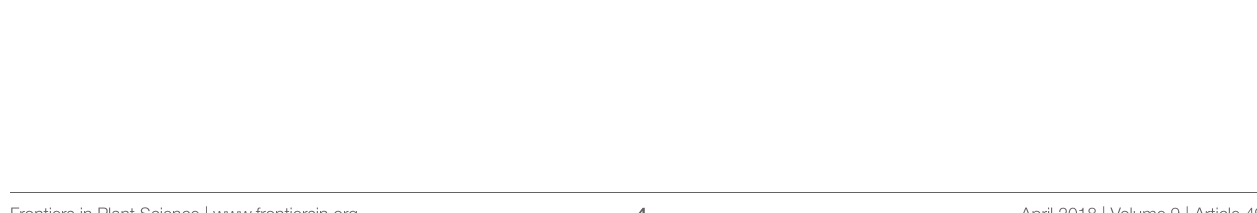
Frontiers in Plant Science | www.frontiersin.org